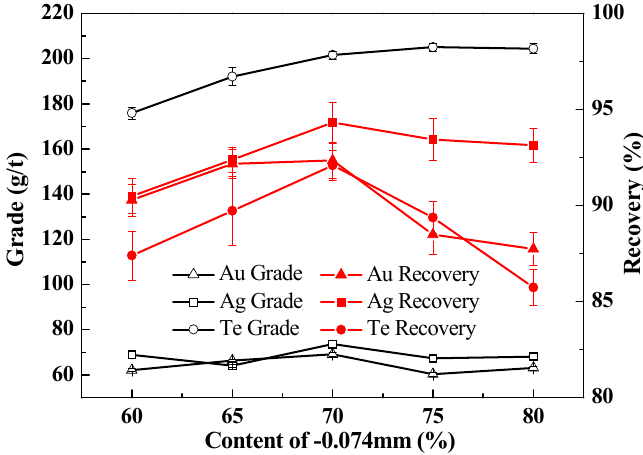
Figure 3. Flotation recovery and grade of Te, Au, and Ag as a function of the ore particle size value (pulp density: 33%; pulp pH value: 8; butyl xanthate: 120 g/t).